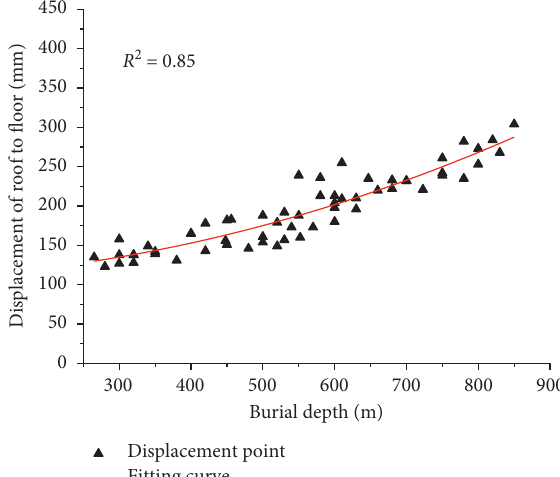
Figure 18: 60m away from the working face.